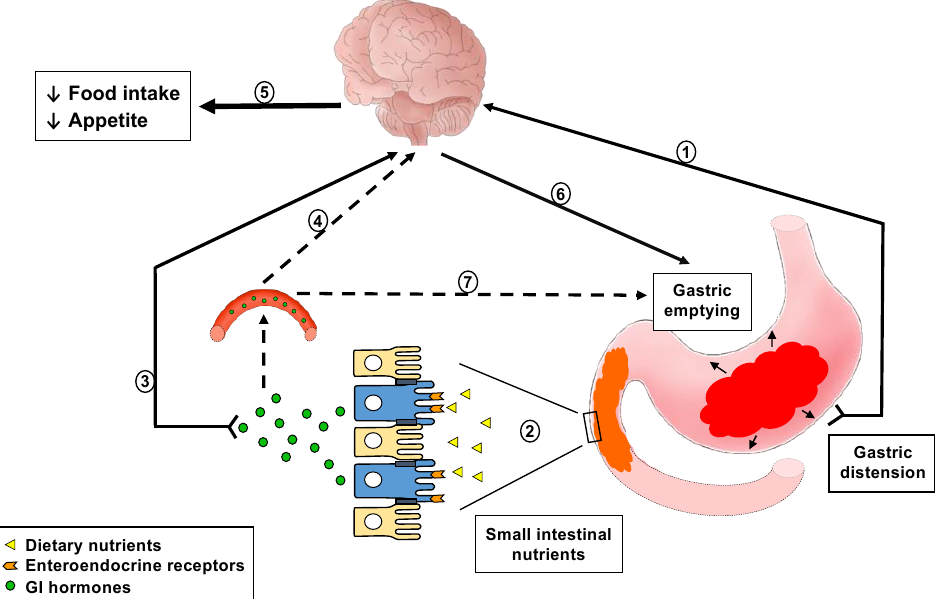
Figure 1. Schematic representation of the gastrointestinal (GI) sensing of meal-related stimuli, and effects on GI functions (specifically gut hormone release and slowing of gastric emptying), appetite and energy intake. Meal ingestion initially induces gastric distension, which activates mechanoreceptors on vagal afferents that terminate in the gastric wall and transmit this signal to the central nervous system (1). As chyme enters the small intestine in the process of gastric emptying, nutrients are sensed by receptors located on enteroendocrine cells, triggering GI hormone secretion (2). GI hormones convey meal-related information to the brain involving various pathways, including activation of hormone-specific receptors on vagal afferent endings (3) or following transport through the blood stream (4). Together, these inputs are conveyed to higher brain centres to modulate eating behaviour, appetite and energy intake (5), as well as feedback regulation of GI motor functions, particularly pyloric pressures, associated with the slowing of gastric emptying (6). The latter can also occur through endocrine pathways (7).